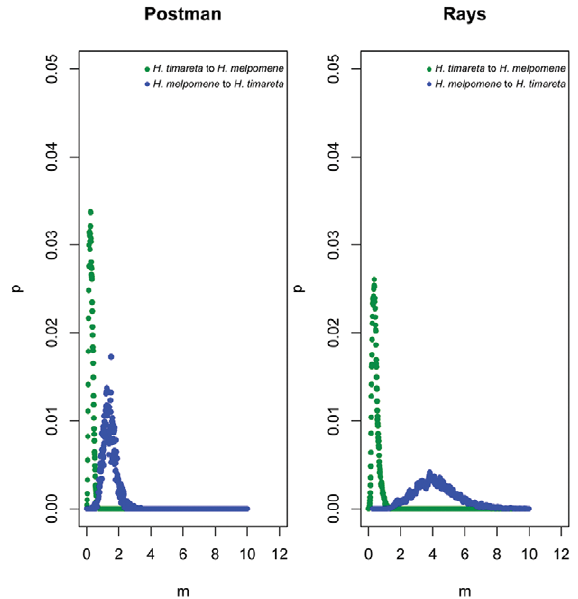
Figure 5. Directional introgression at HmB453k . Bayesian poste- rior probability distributions for the introgression rate (m) at HmB453k between H. melpomene and H. timerata in the rayed phenotypes, between H. melpomene , H. timerata and H. heurippa in the red-banded phenotype. Blue corresponds to introgression from H. melpomene to H. timareta whereas green corresponds to introgression in the other direction.